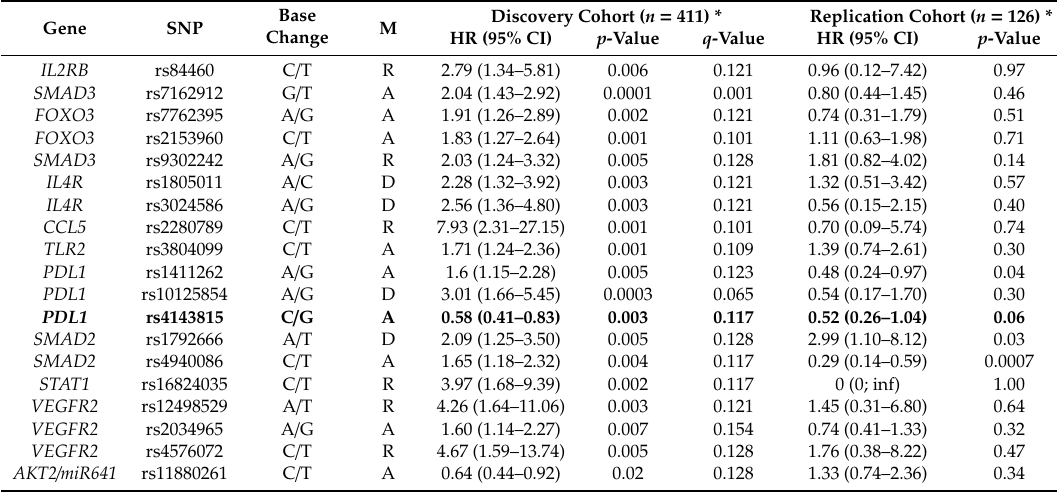
Table 2. Association between SNPs and BCR . Hazard ratio (HR) and 95% confidence interval (95% CI) in the discovery ( n = 411) and replication (126) sets according to gene polymorphisms (SNPs) are listed. Only SNPs that were significant ( p < 0.05 and q < 0.15) in the discovery set are reported. Results obtained in the replication cohort are listed. The rs4143815- PDL1 is shown in bold: it presents the same predictive e ff ect in both groups (HR < 1) and is associated with BCR in the replication set with a trend.